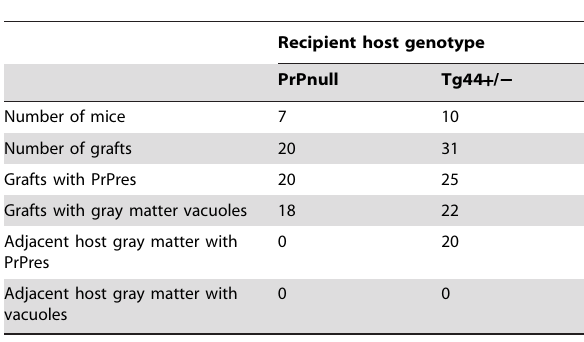
Table 4. Studies of PrPres and gray matter vacuolation in scrapie-infected anchorless PrP tg44 + / 2 mice with C57BL/6 embryonic brain